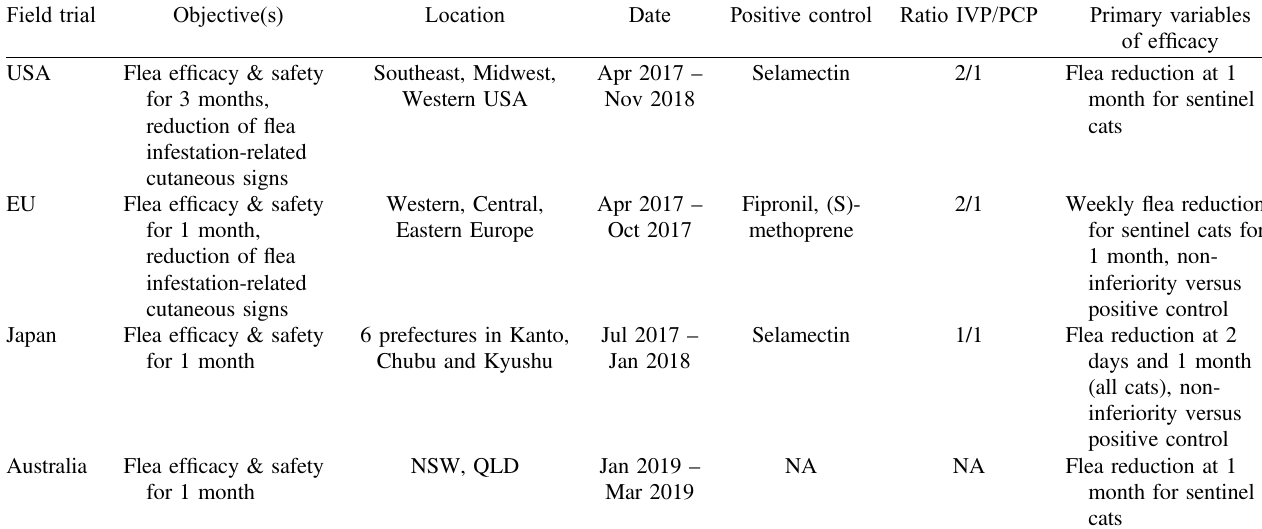
Table 1. Study designs.